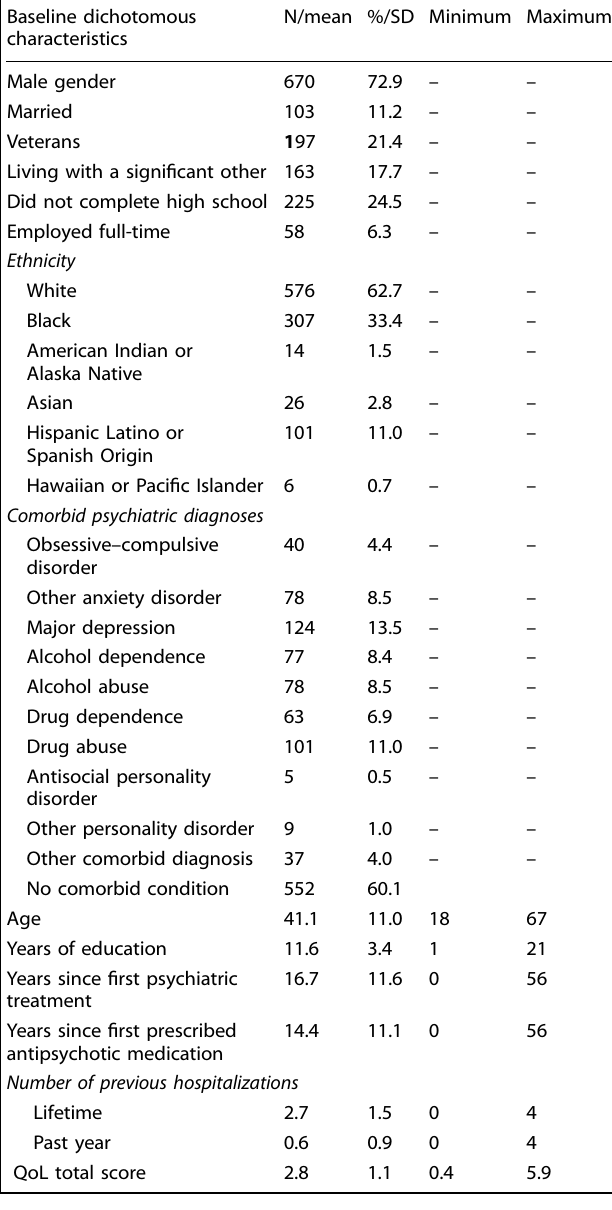
Table 1. Baseline sample characteristics. N = 919. Baseline dichotomous